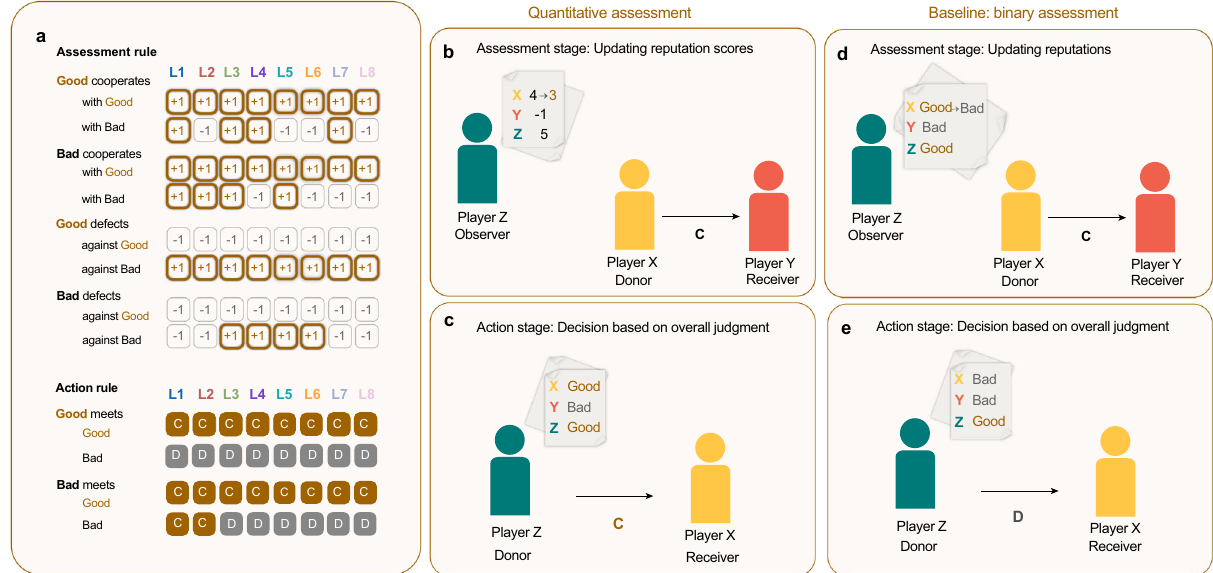
Fig.1|Theleadingeightnormswithquantitativeassessment.a Weconsiderthe leading eight norms 28,33 . Each norm consists of anassessment rule